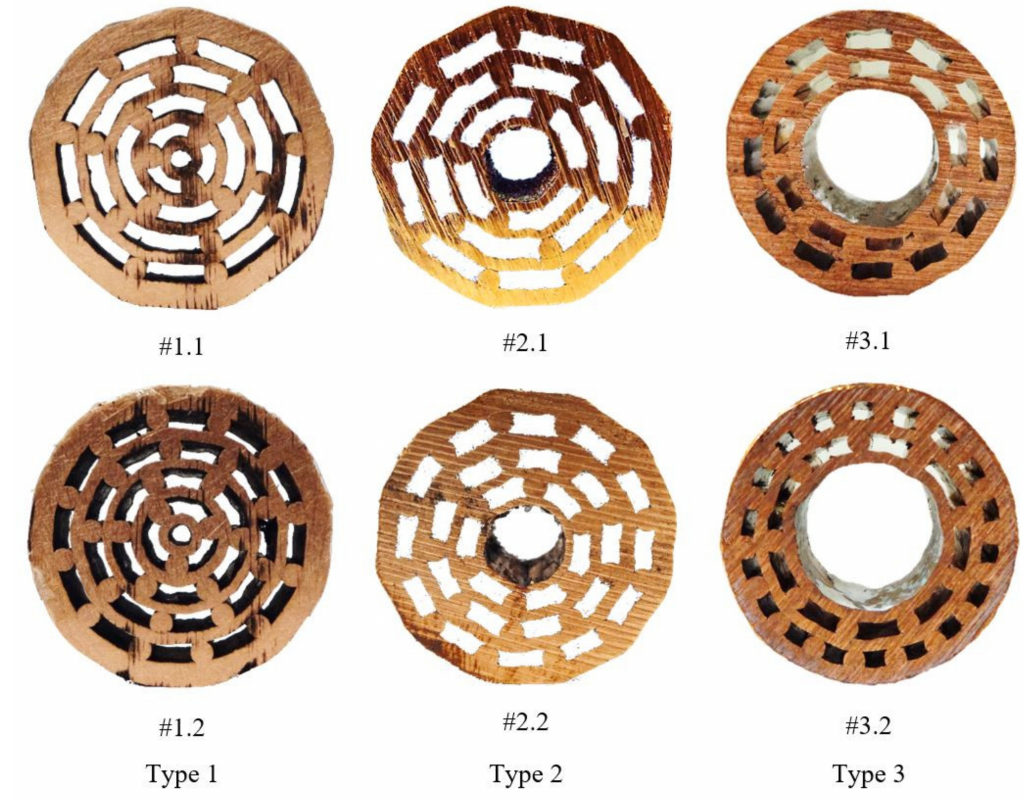
Figure 3. Cross-sections of fabricated